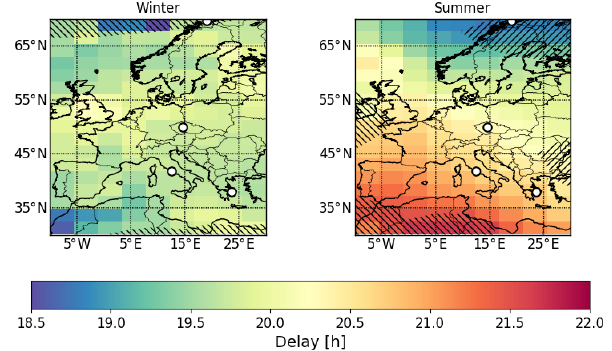
Figure 14. Map of the delay of TEC with respect to EUV in sum- mer (May to August) and winter (November to February) within the time period from January 2011 to December 2013. The delay varies between ≈ 18 . 6 and ≈ 21 . 7h. Regions on the map with up- per left to lower right (upper right to lower left) hatching show sig- nificantly greater (smaller) correlations compared to the average of each map ( ± 1 standard deviation). The absolute correlation coef- ficient is ≈ 0 . 28 in summer and ≈ 0 . 17 in winter. The ionosonde stations Tromsø, Pr˚uhonice, Rome, and Athens are marked with the white dots.